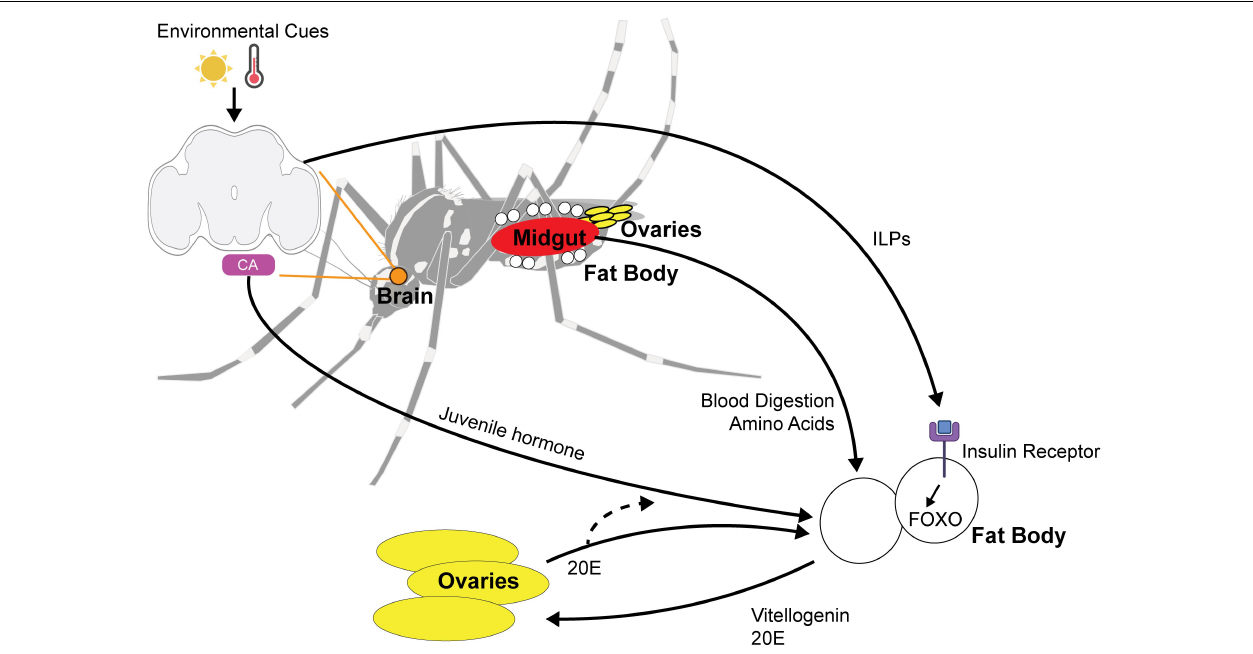
FIGURE 3 | Multi-organ signaling pathways for maternally instigated diapause in female Ae. Albopictus . Environmental cues such as photoperiod and temperature are sensed by the central brain and signal the fat body using (1) ILPs (insulin-like peptides) and (2) juvenile hormone released by the corpora allata (CA). ILPs bind to insulin receptor and activate FOXO pathway. Blood nutrients are digested by the midgut and the integration of environmental cue and blood-fed status trigger the release of vitellogenin and 20E signaling to the ovaries to alter reproduction in diapause state. 20E feedback to the fat body and is likely to affect juvenile hormone